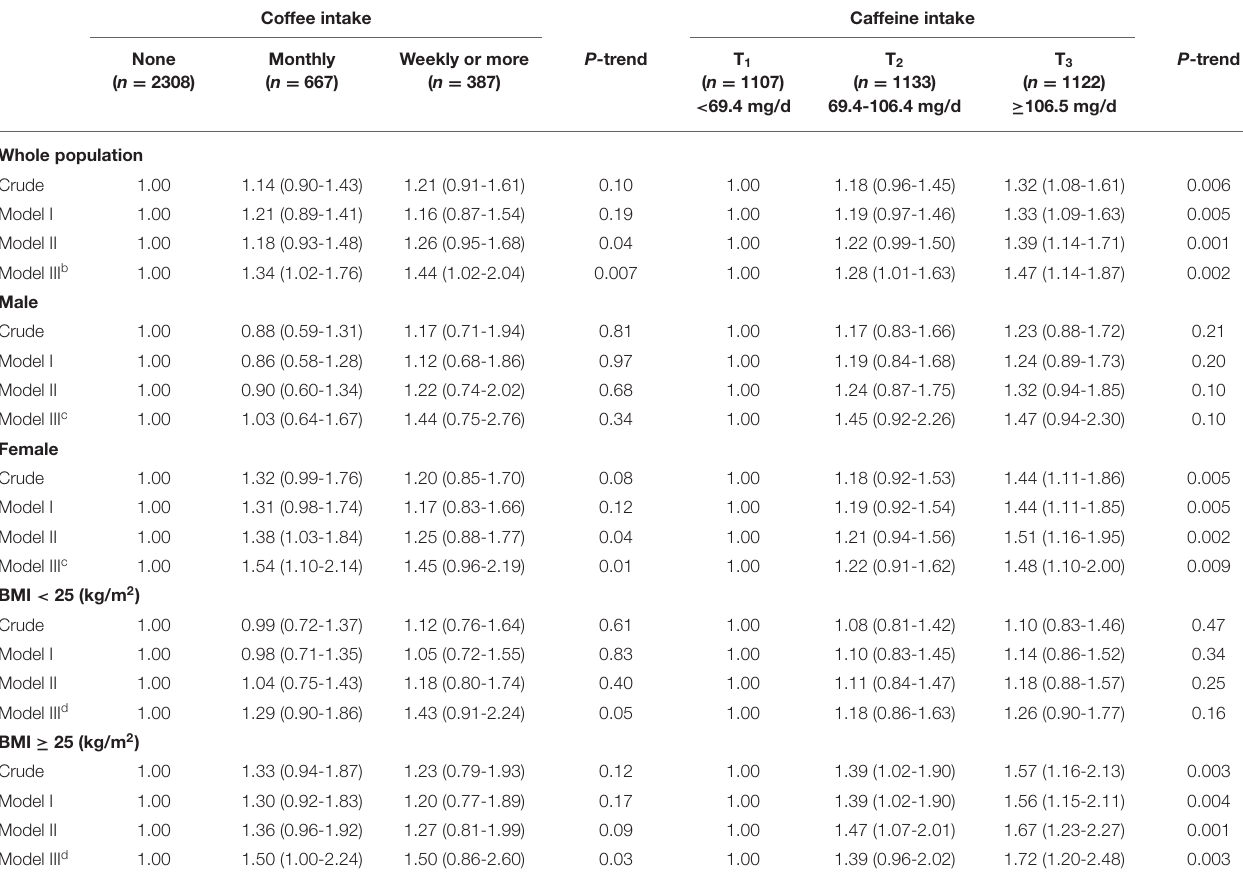
TABLE 2 | Crude and multivariable-adjusted ORs and 95% CIs for IBS across categories of coffee and caffeine intake a . Coffee